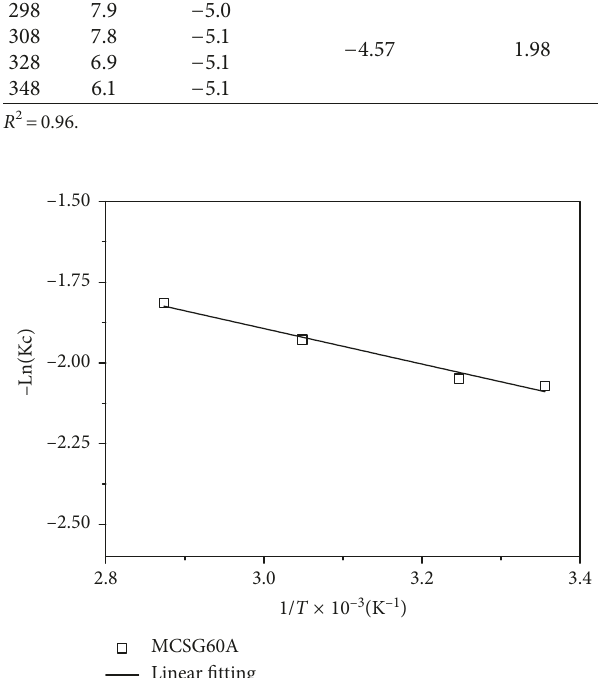
Figure 6: Experiment data fitting of equation